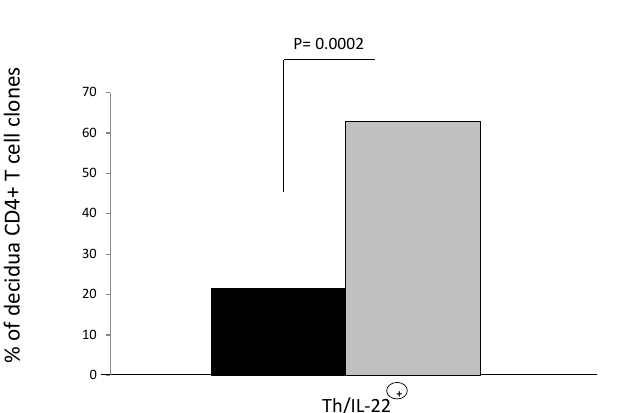
Figure 4. Prevalence of CD4+ T helper cells producing IL-22 (Th/IL-22+) in the decidua of those experiencing successful pregnancy. The levels of IL-22 and the levels of IL-4, IL-13, IL-5, IL-17A, IL-17F, and IFN- γ have been measured in the supernatants of the CD4+ T cell clones derived from deciduae of those experiencing unexplained recurrent abortion (URA) and those experiencing successful pregnancy (Experiment 1 in section 4.3). The percentage of CD4+ T cells producing IL-22 (Th/IL-22+) in the decidua of those experiencing successful pregnancy and the percentage of T helper cells producing IL-22 in the URA deciduae have been calculated. The statistical analysis was performed with chi-square test.